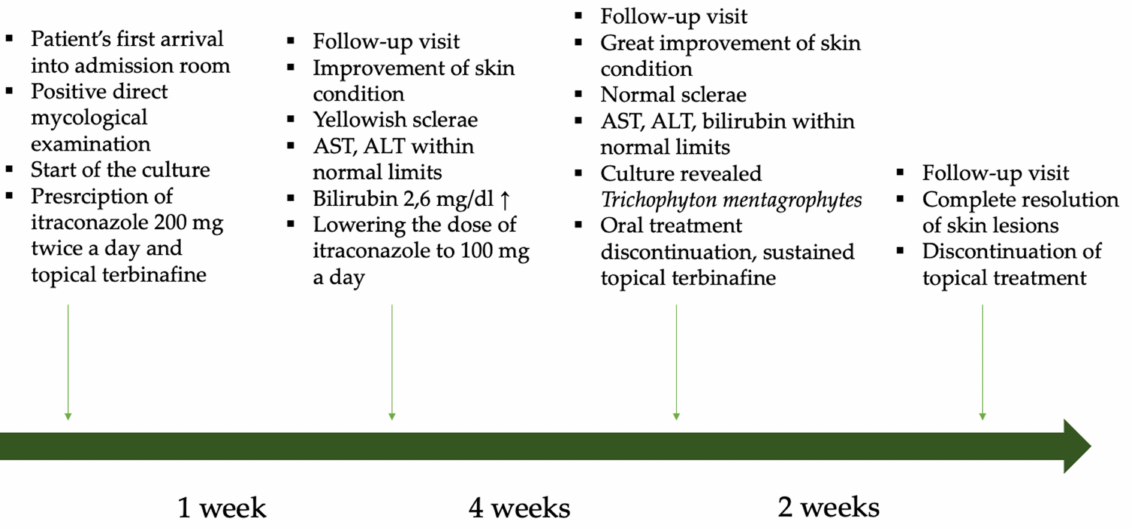
Figure 5. The diagram illustrating the whole patient’s